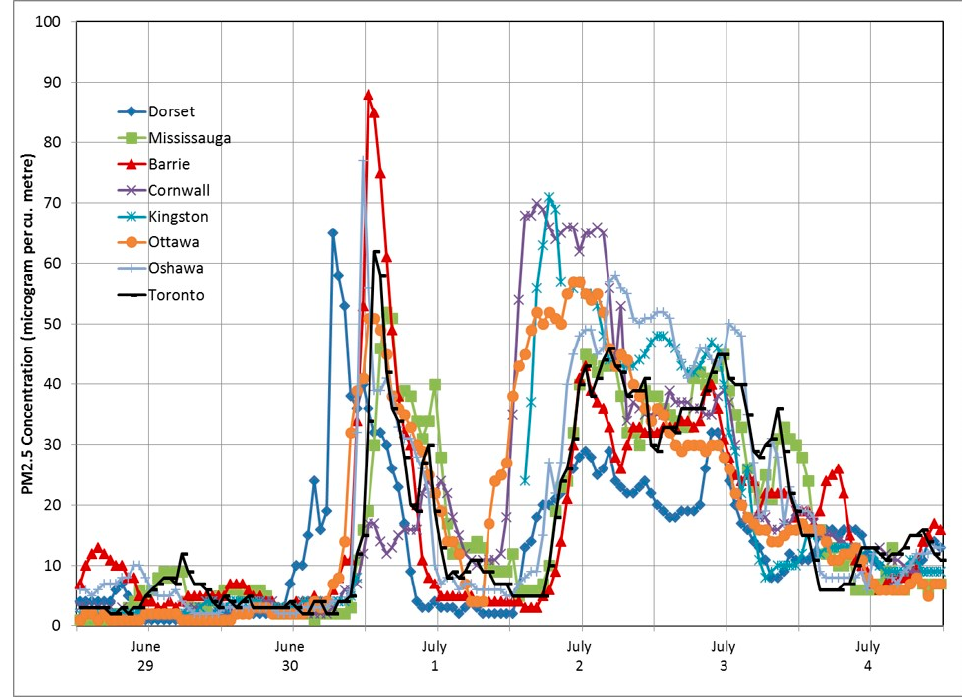
Figure 15. PM2.5 hourly concentrations, 29 June–4 July 2013. Dates are shown at Local Time 12:00.